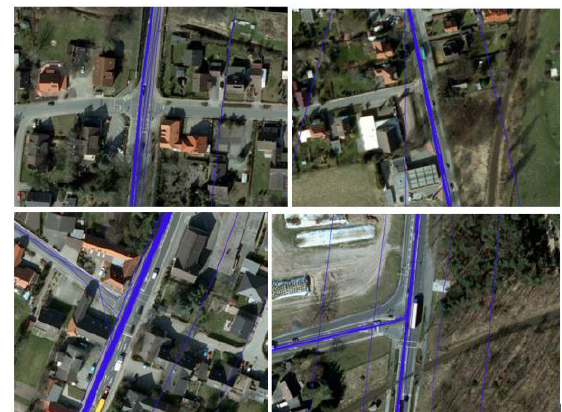
Figure 2. Upper-left: Intersection where no samples (trajectories) exist from all participating road segments that compose the intersection. Upper-right: T-junction where no samples (trajectories) exist from the secondary participating to the junction road. Lower-left: Traffic light-controlled T- junction, where only three samples exist in the dataset that turn